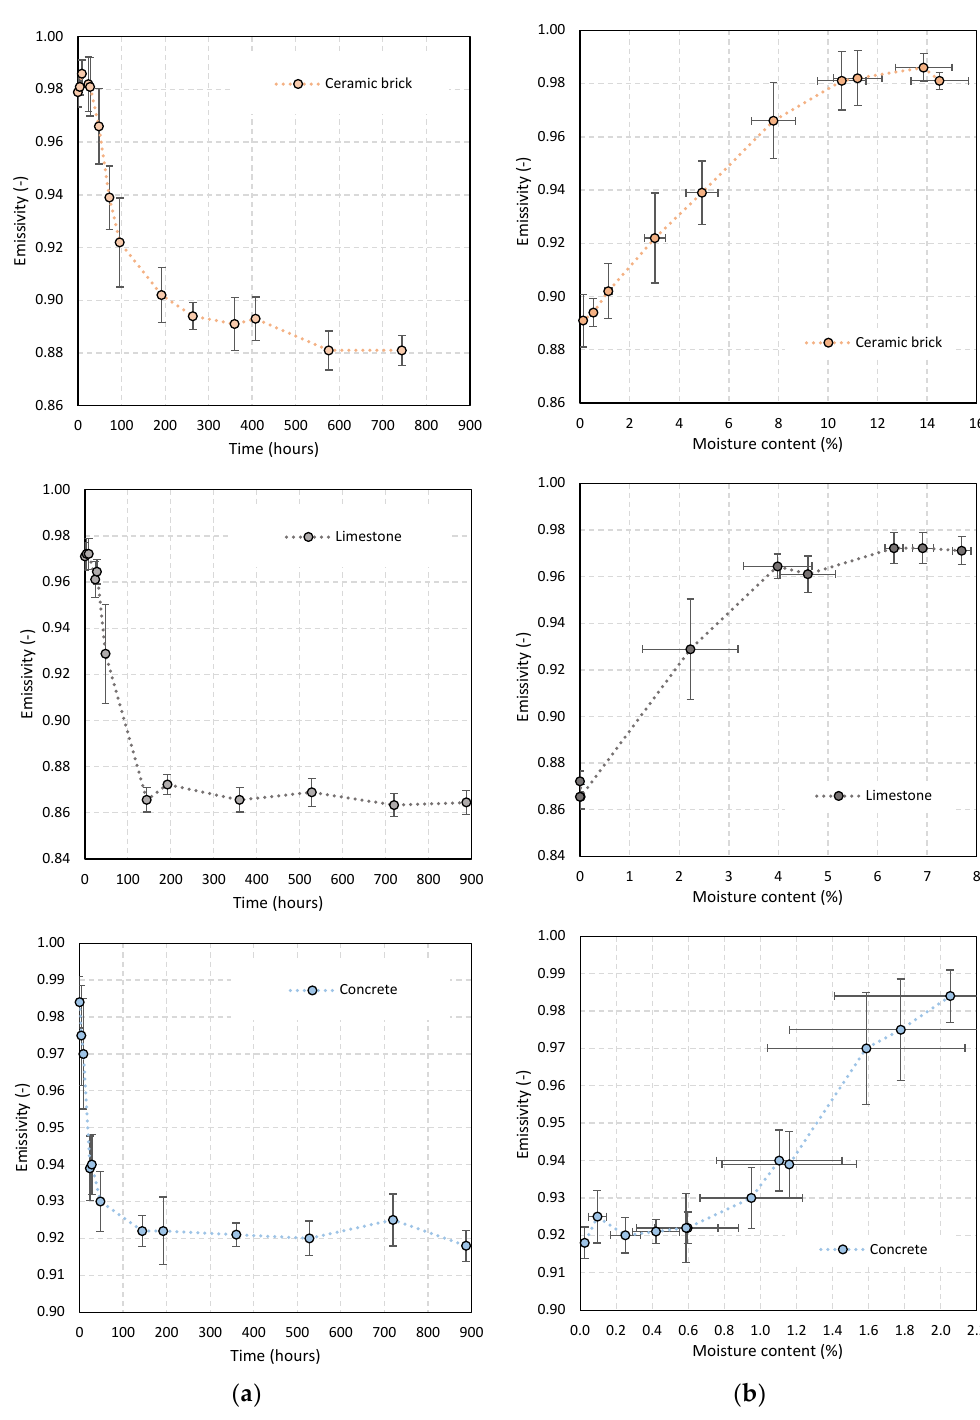
Figure 4. ( a ) Emissivity versus time; ( b ) emissivity versus moisture content.